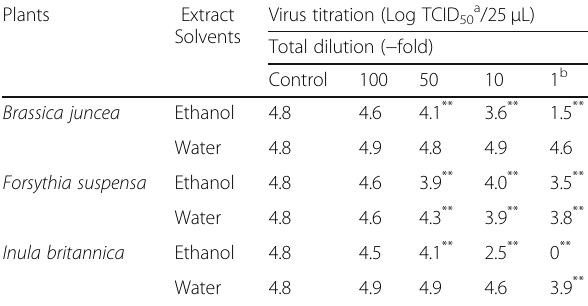
Table 3 Virus titration of medicinal herb extracts against influenza H1N1 virus A/NWS/33